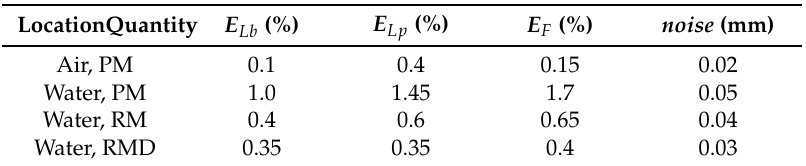
Table 2. Calibration evaluation results (given in %) using specimen ball bar ( E Lb ), frustum of pyramid ( E Lp ), and plane ( E F ), and averaged 3D noise values.